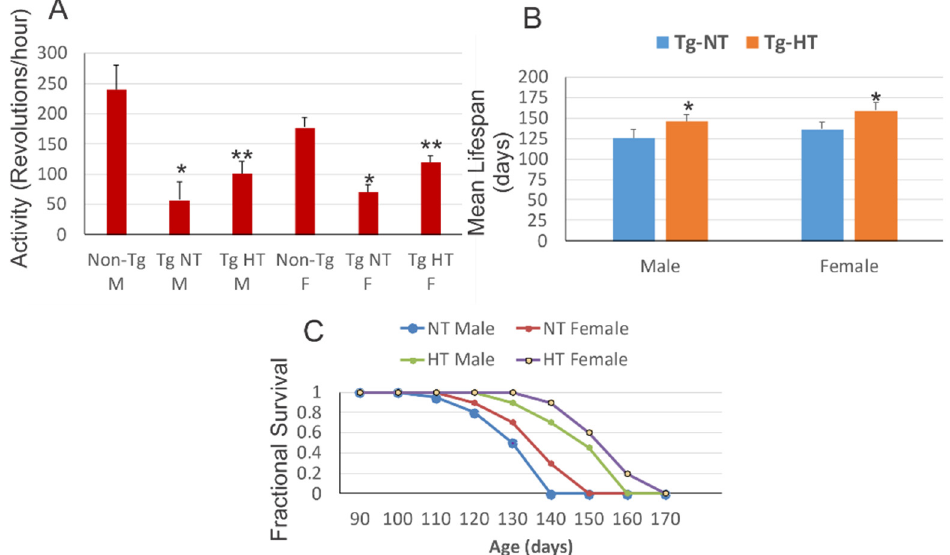
Figure 2. Cold acclimation mitigates neurologic decline and extends survival of male and female hSOD1-G93A tg mice. ( A ) At 10 weeks of age, male and female hSOD1-G93A tg mice that were non-cooled normothermic (Tg-NT) have a significant loss of motor activity (* p < 0.001) compared to sex-matched non-tg mice. Male and female hSOD1-G93A tg mice with hypothermia treatment (Tg-HT) had significantly better motor activity (** p < 0.05) compared to hSOD1-G93A tg mice that were non-cooled normothermic (Tg-NT). ( B ) Cooling male and female hSOD1-G93A tg mice (Tg-HT, orange) increased significantly (* p < 0.01) their mean lifespan compared to non-cooled normothermic hSOD1-G93A tg mice (Tg-NT, blue). ( C ) Kaplan–Meier curves showing that cooling delayed